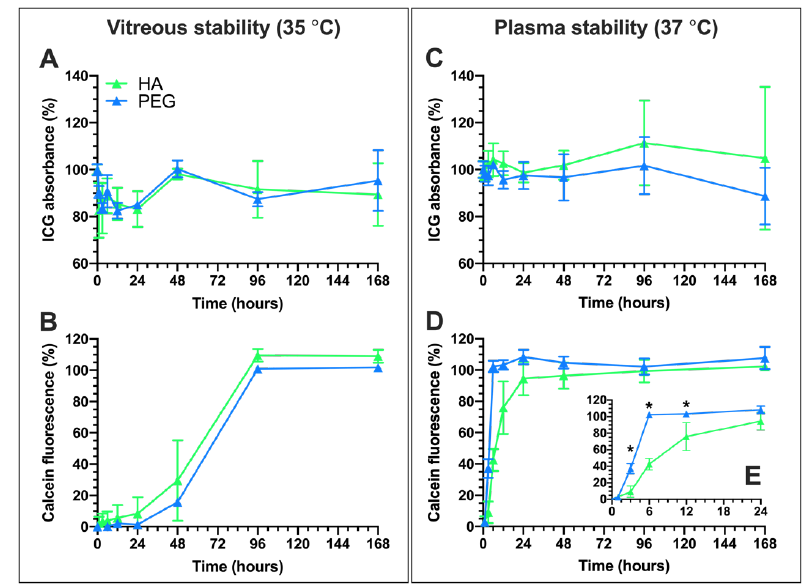
Figure 2. Stability of the HA- and PEG-coated liposomes at physiological temperatures monitored for 168 h (one week) based on ICG absorbance ( A , C ) and calcein fluorescence ( B , D ) in porcine vitreous ( A , B ) and human plasma ( B , D ) samples. Liposome solution (25%) was mixed with the biological fluids